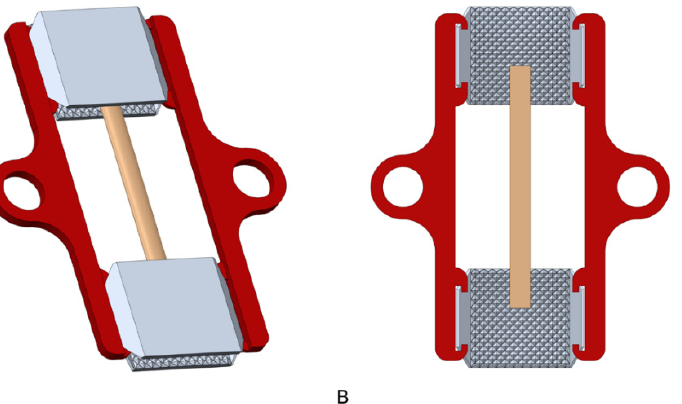
Figure 1. Computer-aided design model of the assembled clamps and holder arms (including the schematic representation of a sample). ( A ) 3D view, ( B ) cross-sectional view.